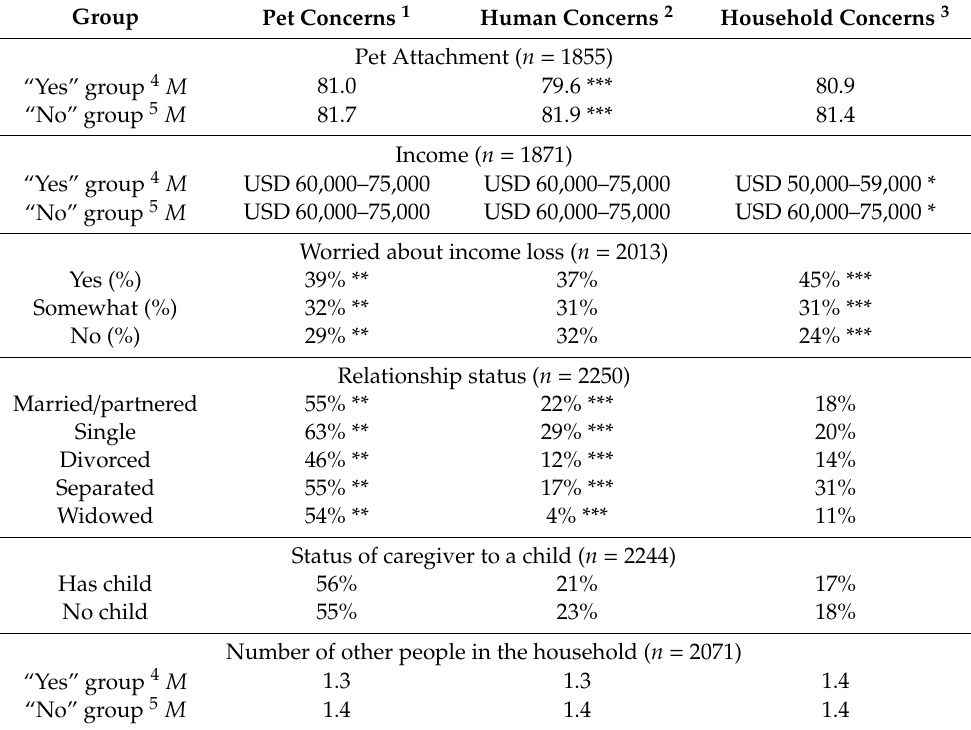
Table 1. Types of concerns expressed by level of pet attachment, yearly family income, worry about income loss due to COVID-19, relationship status, status of caregiver to a child, and number of people in the household.